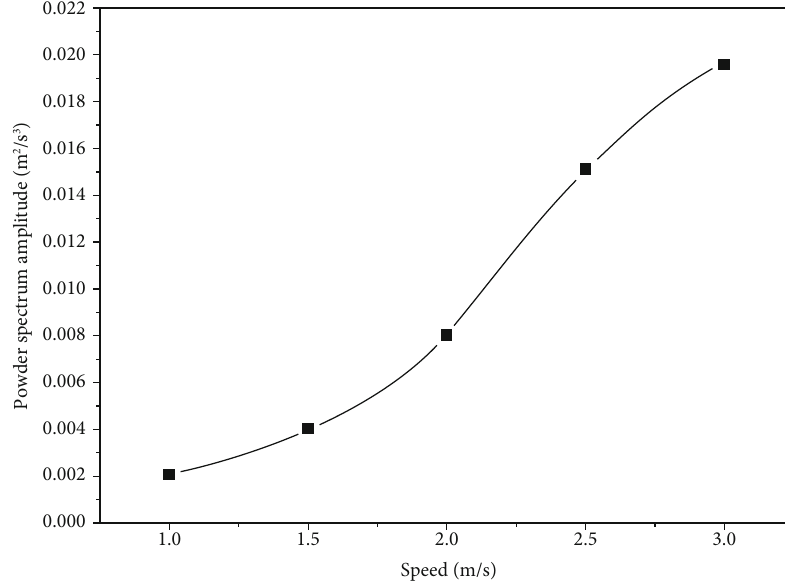
Figure 6: Vibration signal energy of fl uid impacting the pipe